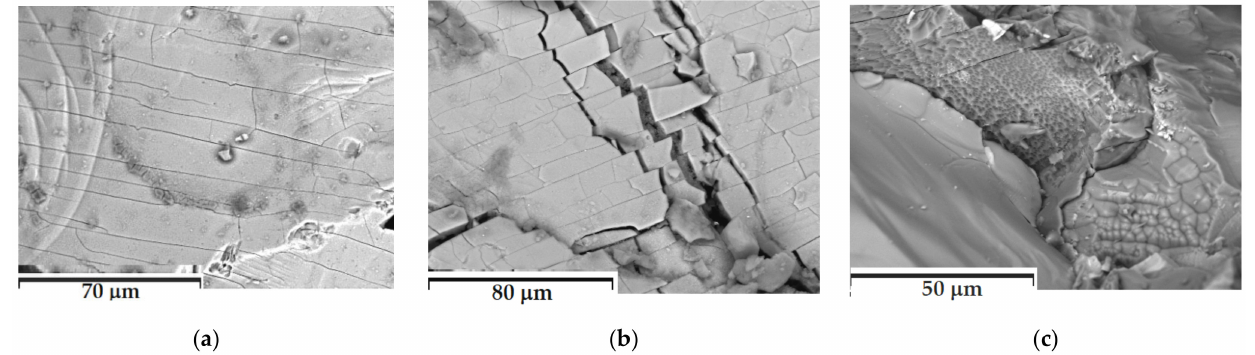
Figure 6. ( a , b ) Eudialyte and ( c ) perovskite surface after treatment by HPEMP ( t treat = 30–90 s). SEM; scale bars: ( a ) 70, ( b ) 80, ( c ) 50 µ